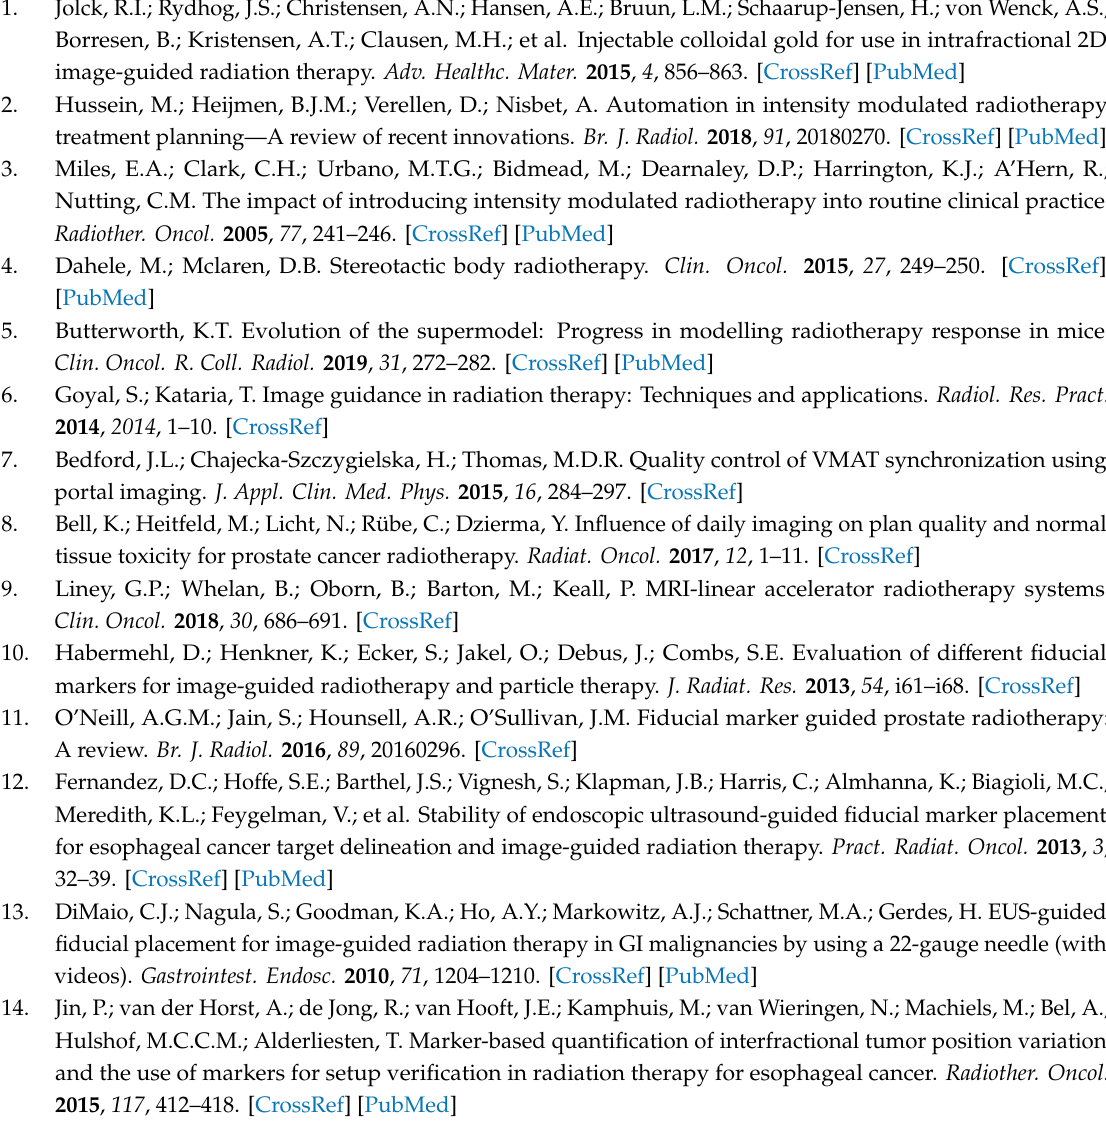
Figure S1: In vivo stability of BioXmark ® after intraperitoneal injection, Figure S2: Re-planned Dose Volume Histogram (DVH) of an LLC tumour receiving single dose 16 Gy irradiation with an intra-tumoral injection of BioXmark ® , Table S1: Average CBCT values for air, tissue, bone and BioXmark for control and BioXmark implanted mice, Table S2: Maximum values for segmentation windows for control and BioXmark implanted